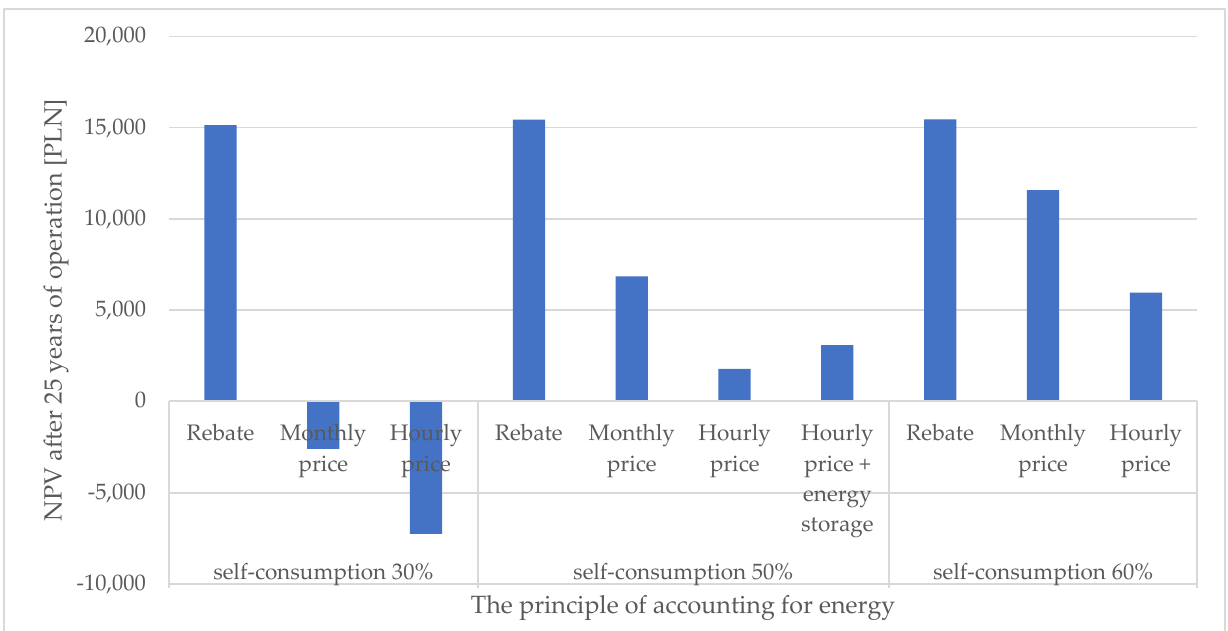
Figure 16. Graph of changes in NPVs for the PV installations analysed.